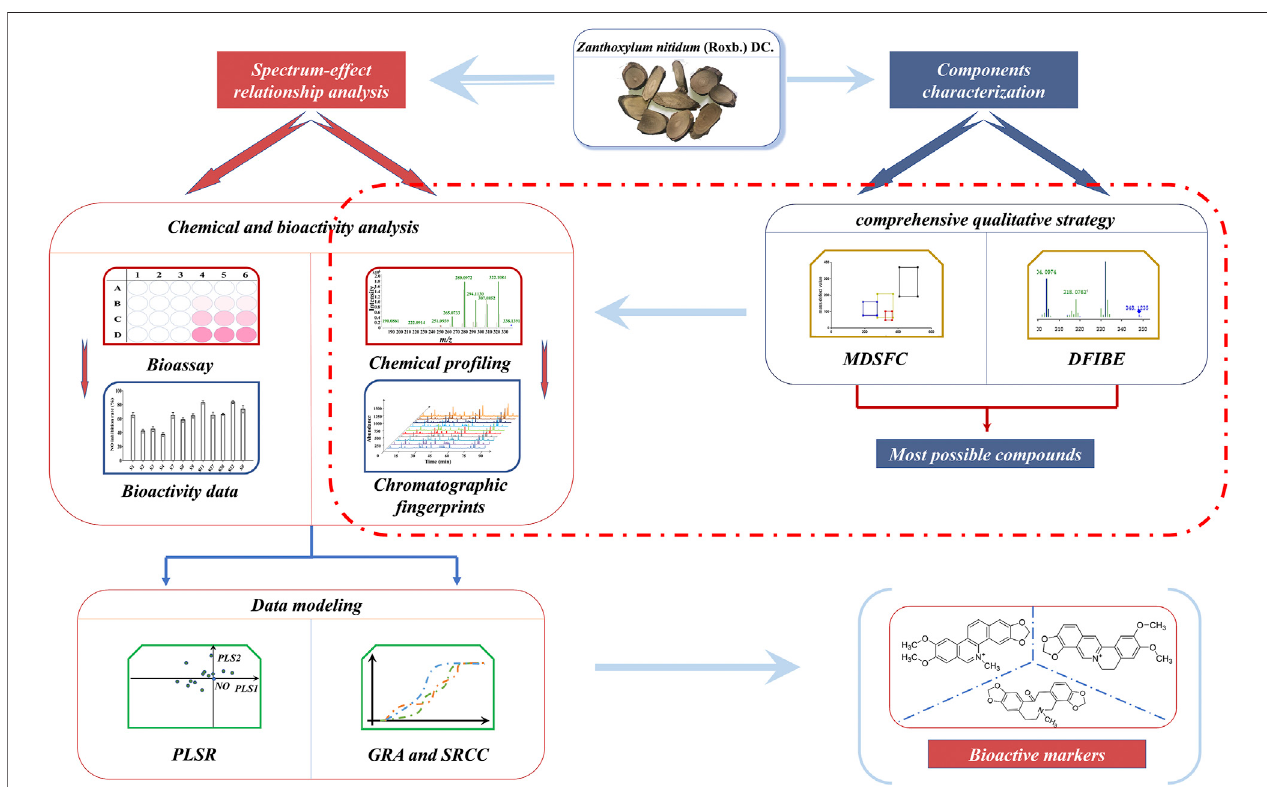
FIGURE 1 | The strategy for discovering bioactive markers in Zanthoxylum nitidum (Roxb.) DC. (ZN) by ultrahigh-performance liquid chromatography-quadrupole time-of- fl ight mass spectrometry (UHPLC Q-TOF MS) coupled with comprehensive fi ltering approaches.